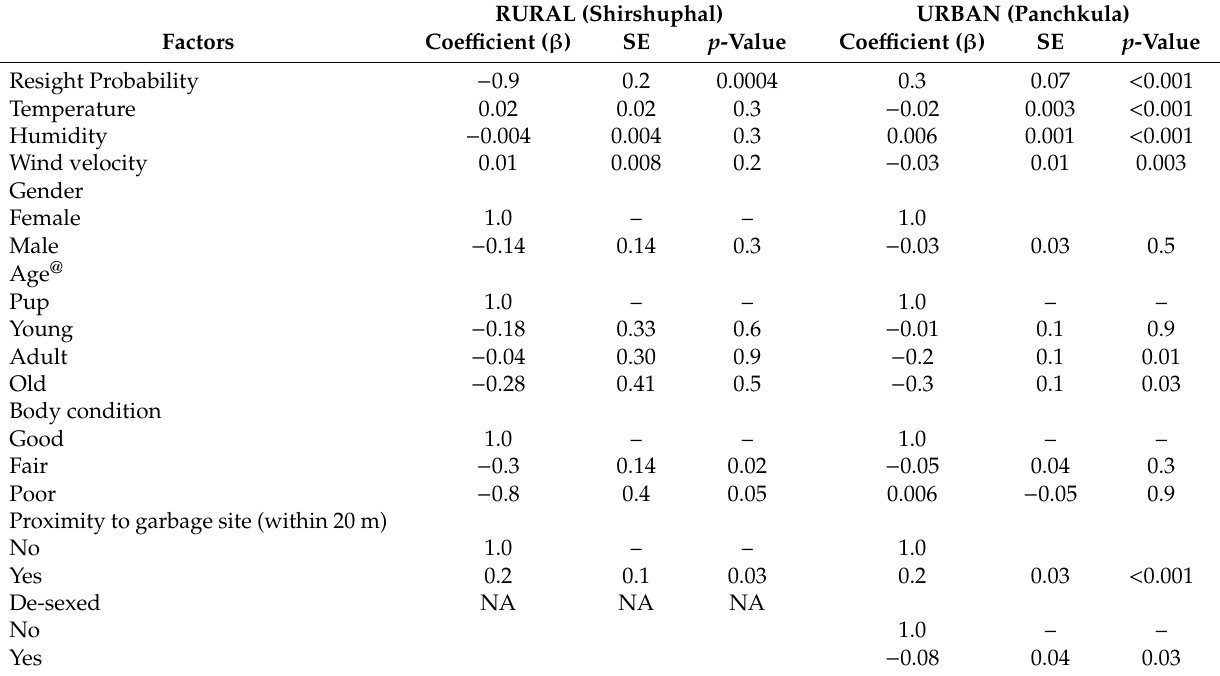
Table 3. The coe ffi cients, standard error and p -values of the univariable generalised linear mixed models for the regression of predictor variables on the actual group size of FRD * in rural Shirsuphal # and urban Panchkula † in